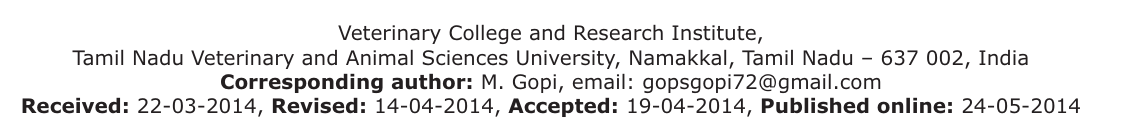
supplementation on serum and bone minerals and leg weakness mortality in